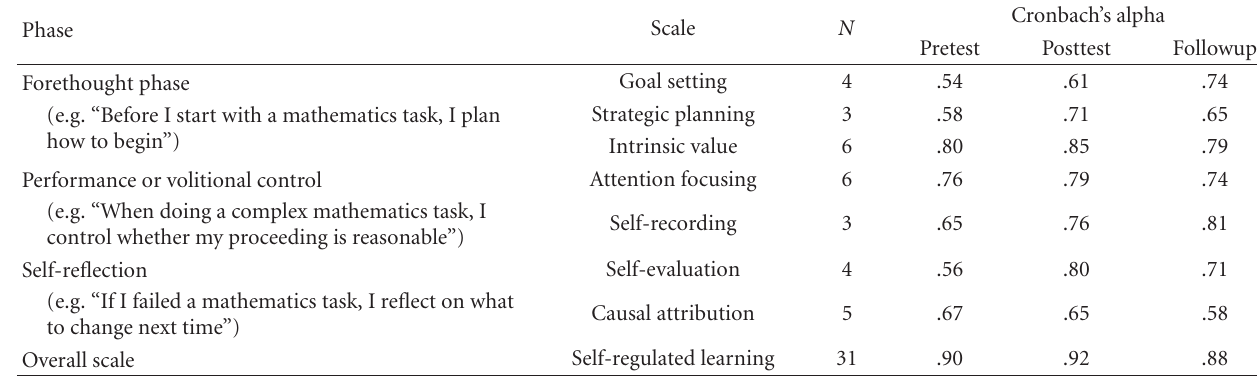
Table 3: Reliabilities of the self-regulated learning